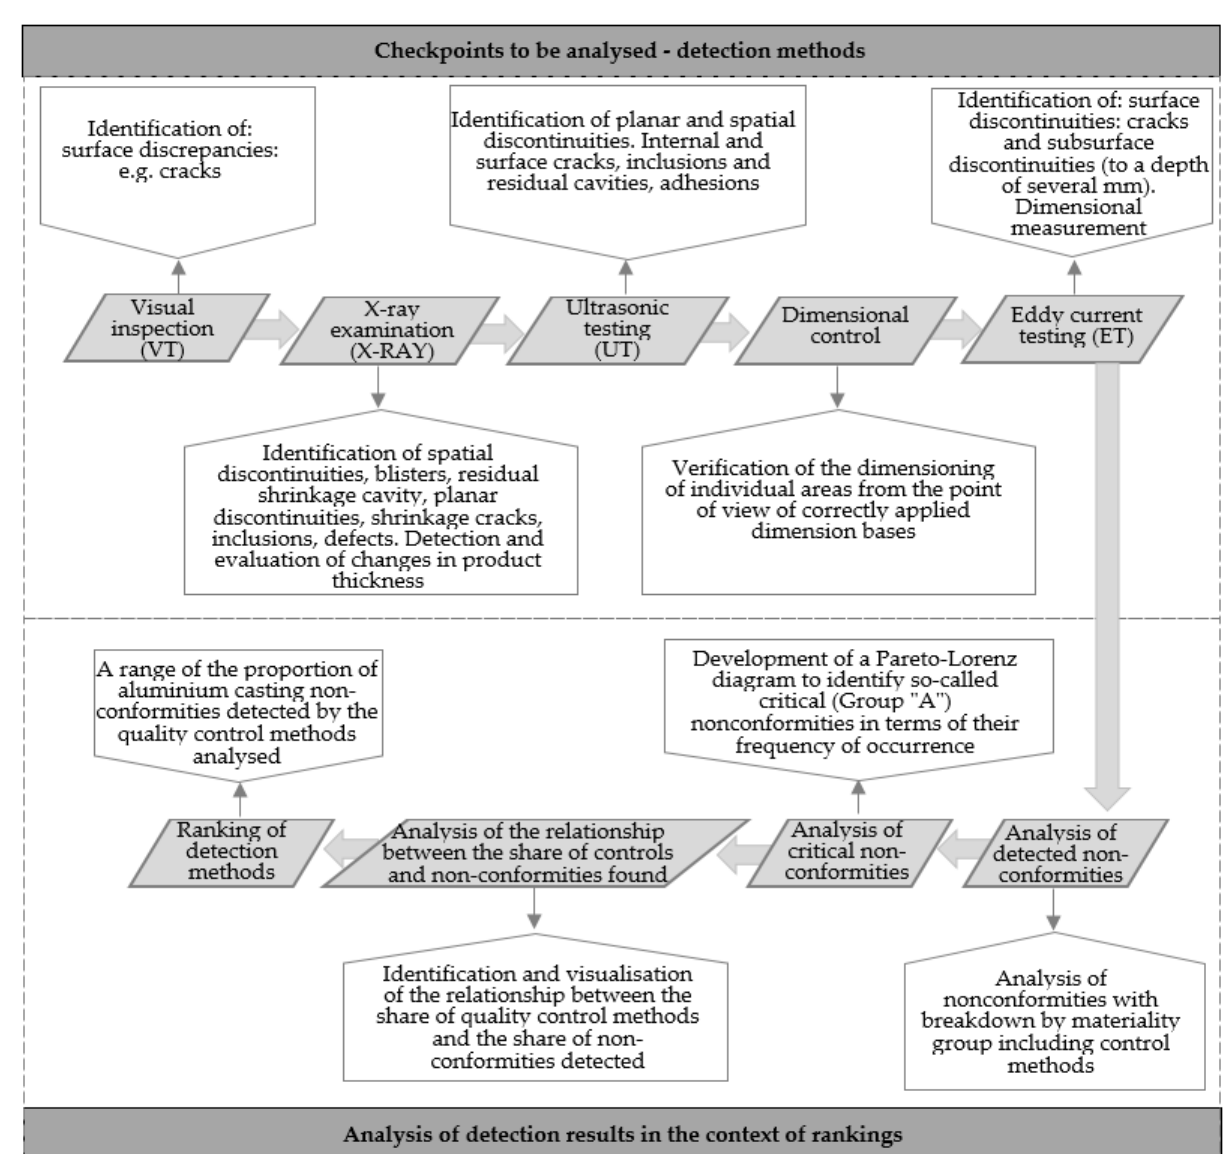
Figure 1. Overall model concept.